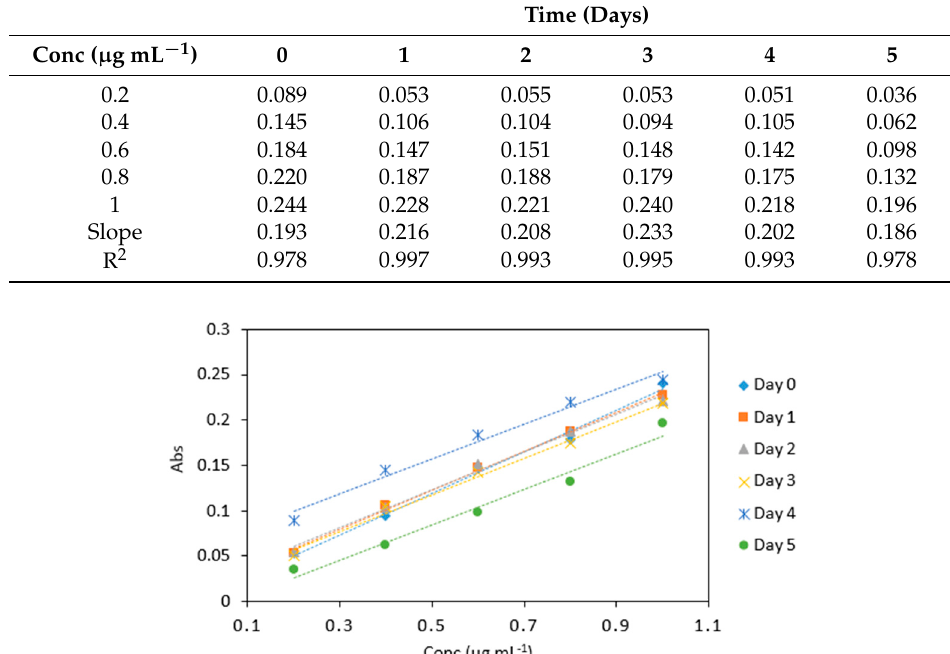
Table 6. Average absorbance values for arsenic samples (0.2–1 µ g mL − 1 ) analyzed periodically on day 0, 1, 2, 3, 4 and 5 under the same conditions with the same potassium iodate and hydrochloric acid mix. All measurements were carried out in triplicate ( n = 90).